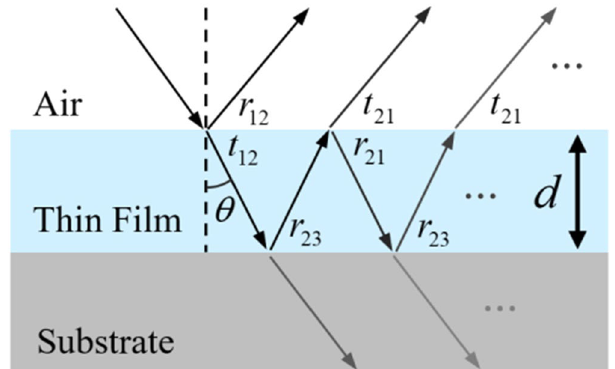
Figure 1. Schematic diagram of multiple reflections and transmissions taking place within the thin film layer of a specimen ( r 12 : Fresnel reflection coefficient of light incident from air to the film, t 12 : Fresnel transmission coefficient of light incident from air to the film, r 23 : Fresnel reflection coefficient of light incident from the film to the substrate, r 21 : Fresnel reflection coefficient of light incident from the film to air, t 21 : Fresnel transmission coefficient of light incident from the film to air, d : Film